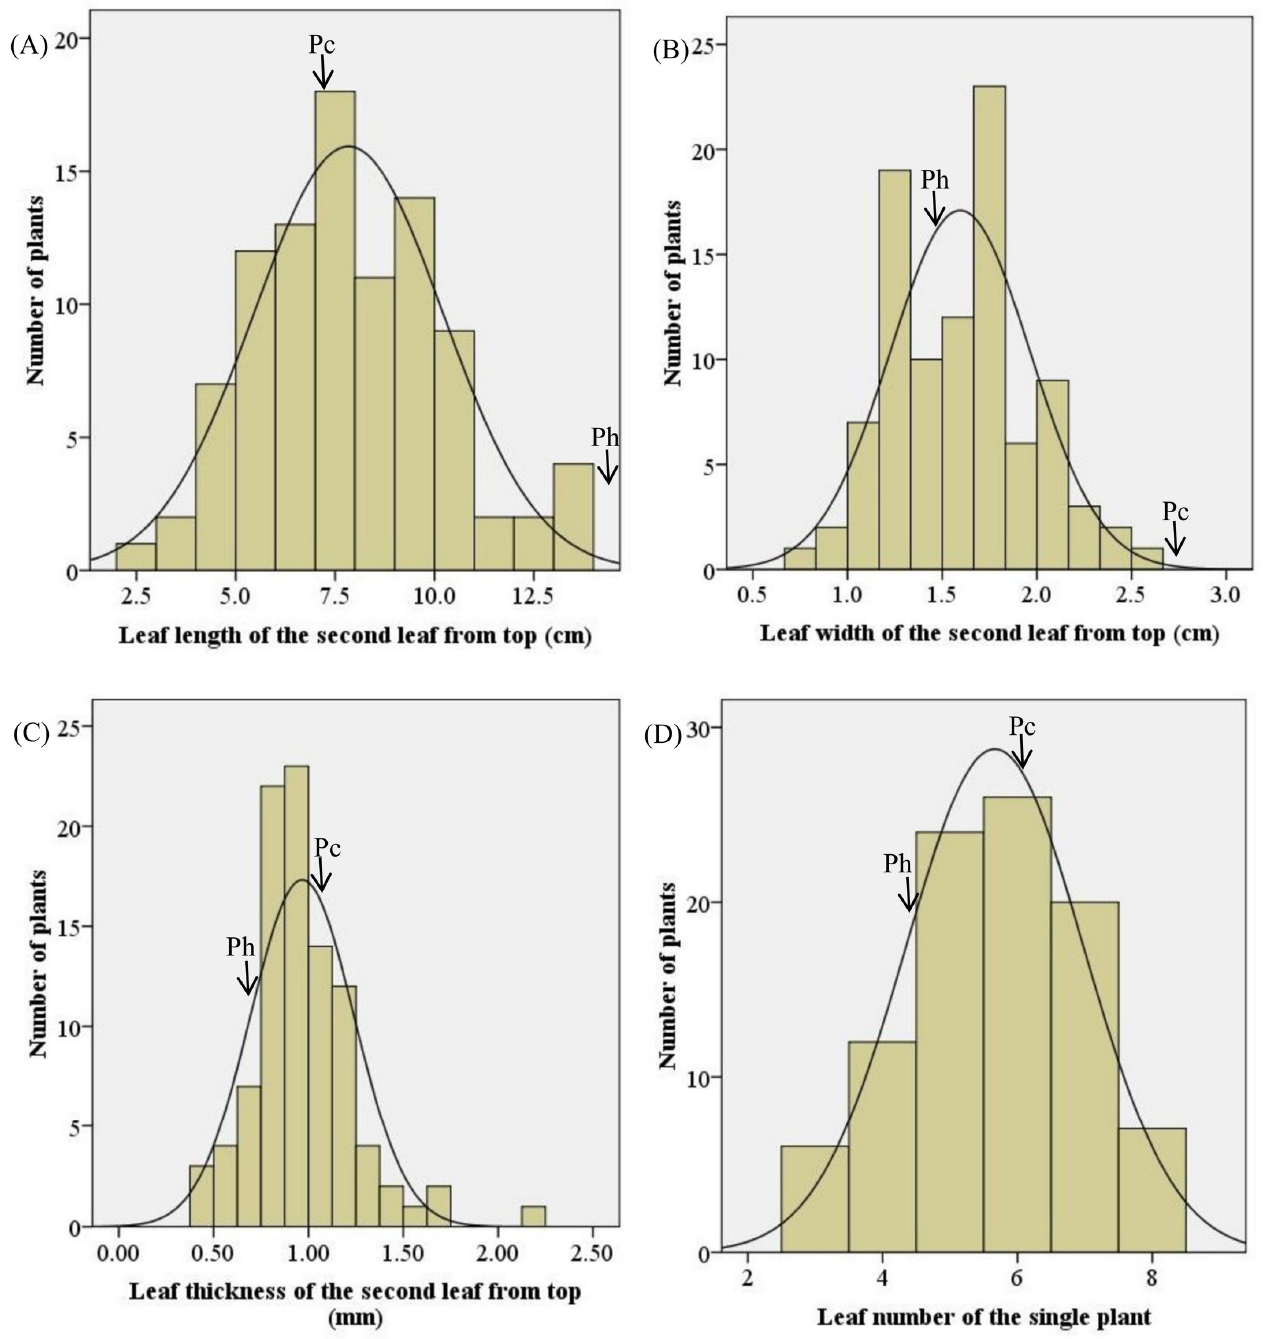
Figure 1. The distribution of four leaf-related traits including leaf length ( A ), leaf width ( B ), leaf thickness ( C ), and leaf number ( D ) in the F1 population. The x -axis shows the ranges of phenotypic traits and the y -axis represents the number of individuals in the F1 population. The values of the two parents P. concolor (Pc) and P. hirsutissimum (Ph) are indicated by arrows.